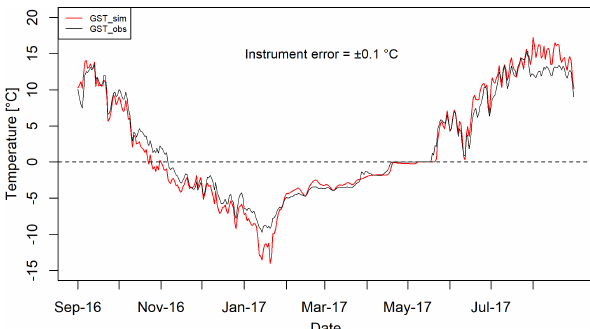
Figure 2. Comparison of hourly observed and GEOtop-simulated snow depth at South Pullu (4727ma.s.l.) from 1 September 2015 to 31 August 2017. The black line denotes the snow depth measured in the field by the SR50 sensor. The red (Snow depth_ESOLIP) and green (Snow depth_field) lines in the plot indicate the GEOtop- simulated snow depth based on ESOLIP-estimated precipitation and precipitation measured in the field, respectively.